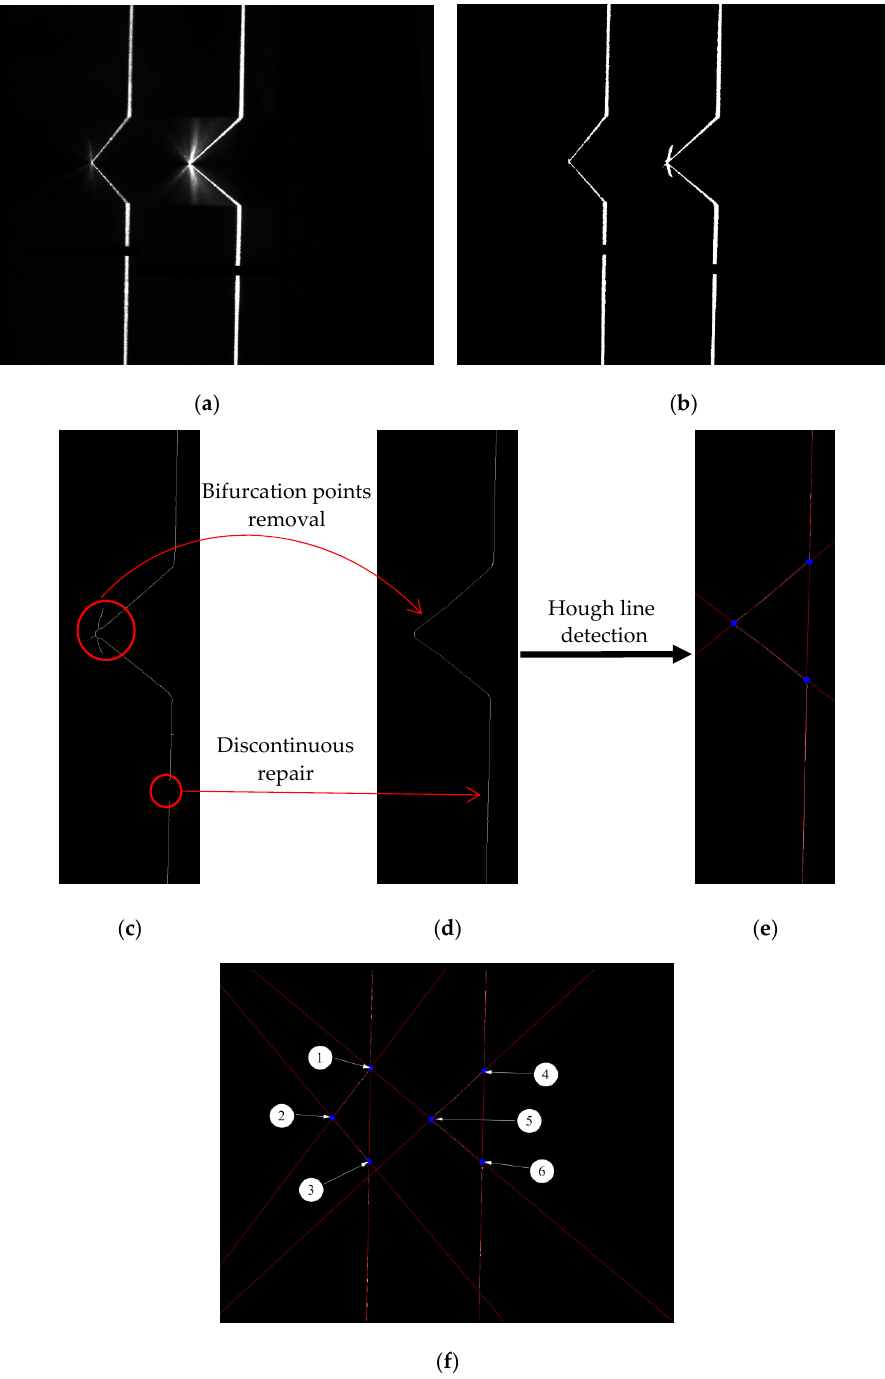
Figure 5. Laser lines image processing and feature extraction: ( a ) original laser lines image, ( b ) pre- processing for laser lines image, ( c ) skeleton thinning processing for ROI, ( d ) defect repair for ROI of single pixel laser line, ( e ) Hough line detection for ROI of single pixel laser line and ( f ) feature extraction of laser lines image.